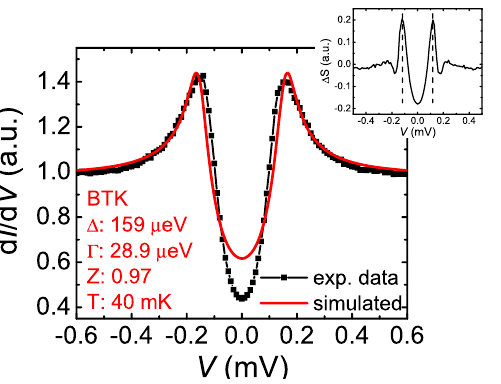
Figure 5. Additional gap-like feature in point contact spectrum of the NbSe 2 /16 QL Bi 2 Se 3 heterostructure at 40 mK. A point contact spectrum of the NbSe 2 /16 QL Bi 2 Se 3 heterostructure at 40 mK (black) plotted together with a BTK model simulated curve using the parameters shown in the bottom left of the figure (red). The top right inset shows the conductance difference between the experimental data and the simulation as a function of bias V . The dash lines mark positions of peaks at ~120 μ V.